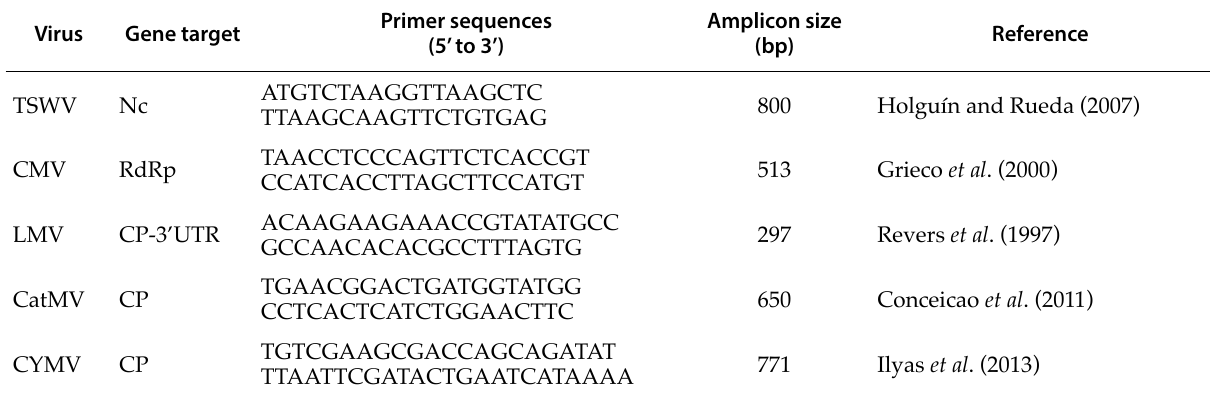
Table 1. List of virus-specific primers used in PCR\RT-PCR. Nc: Nucleocapsid protein; CP: capsid protein; RdRp: RNA- dependent RNA